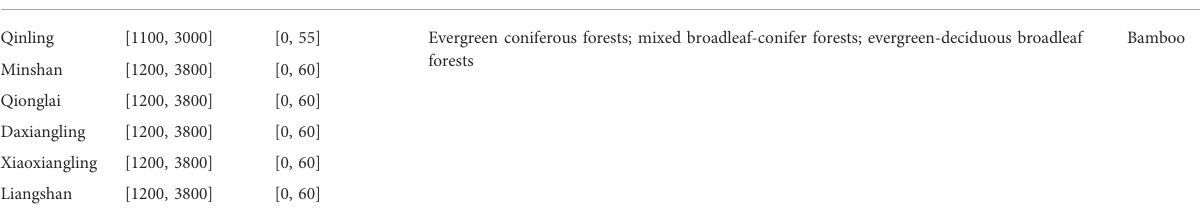
TABLE 2 Potential habitat assessment criterion for the giant panda (Kong et al.,